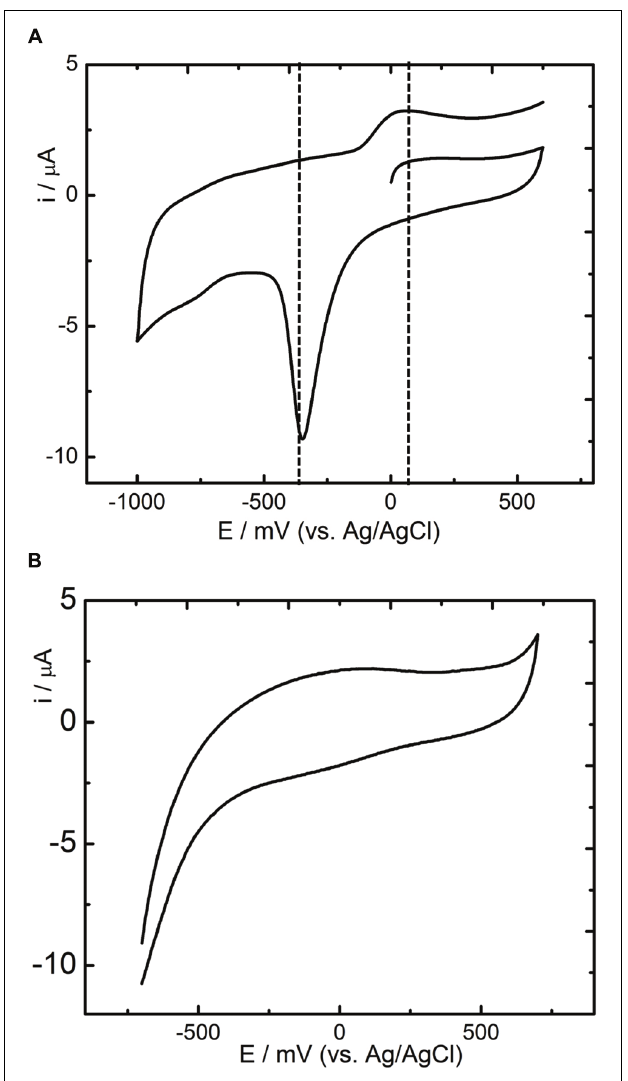
FIGURE 5 | Cyclic Voltammetry studies of R. palustris strain RP2. (A) Anoxic grown cells; (B) Aerobically grown cells; Scan rate: 5 mV s − 1 .